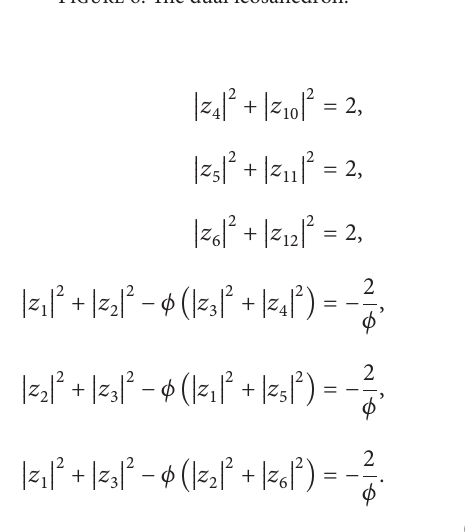
Figure 6: The dual